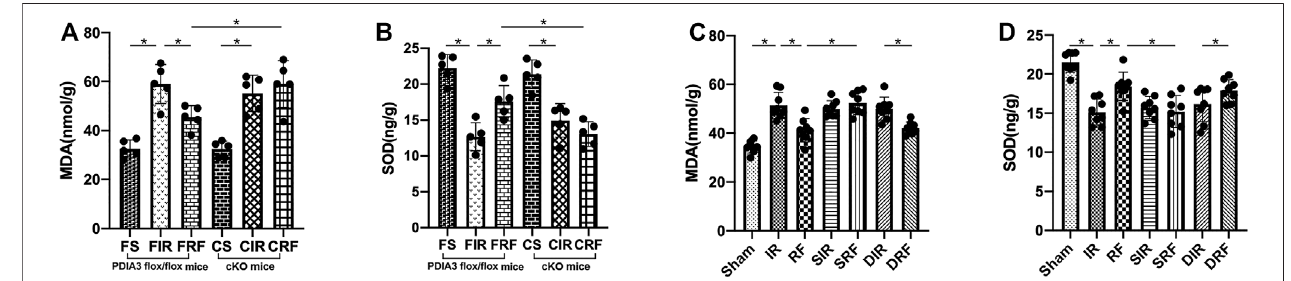
FIGURE 6 | Changes in intestinal mucosa malondialdehyde (MDA) (A,C) and superoxide dismutase (SOD) (B,D) . Groups are the same as in Figure 1 . Data are expressed as mean ± SD, n = 5 – 8. The results were compared by ANOVA with Tukey ’ s post hoc test. * P < .05.